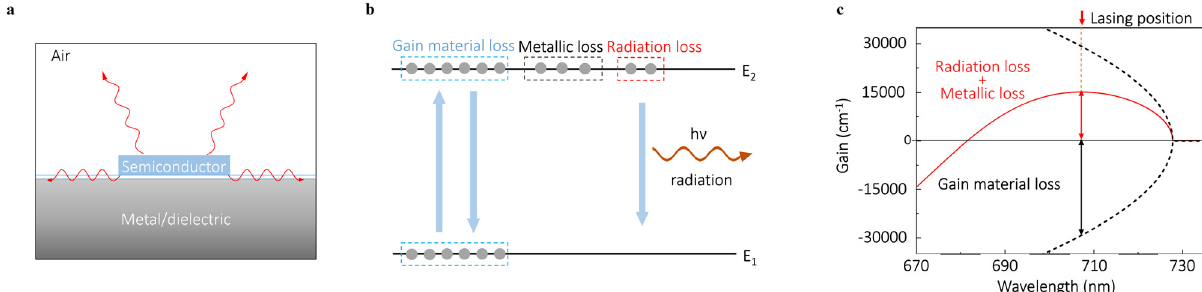
Figure 4: Loss and gain of plasmonic nanolasers. a Thelossofaplasmonicnanolaserconsistsofthreeparts,radiationloss,gainmaterialloss,andmetallicloss. b Toachieveplasmoniclasing state, carriers need to be pumped in the excited energy level to a certain density to provide gain to compensate all the losses of gain material loss,metallicloss,andradiationloss. c Gainspectrumatfulllasingstate.Themaximumgaininthegainspectrumapproximatelyequalstothe sum of the metallic loss and radiation loss. Figure adapted